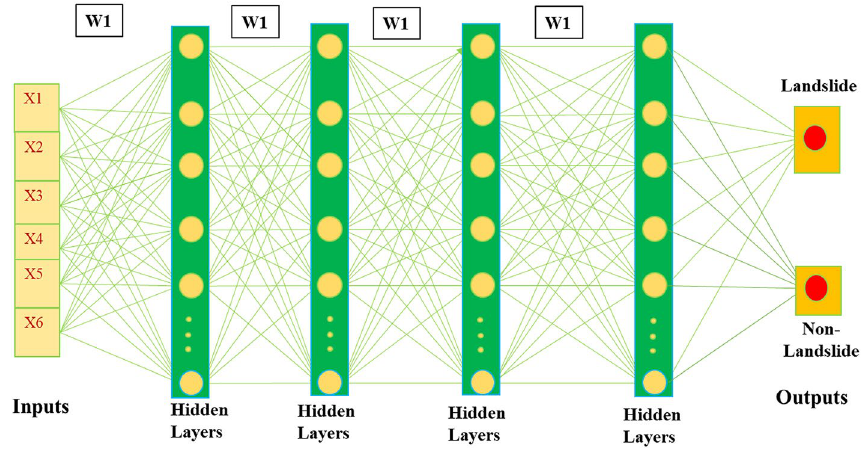
Figure 7. Configuration of the DLNN